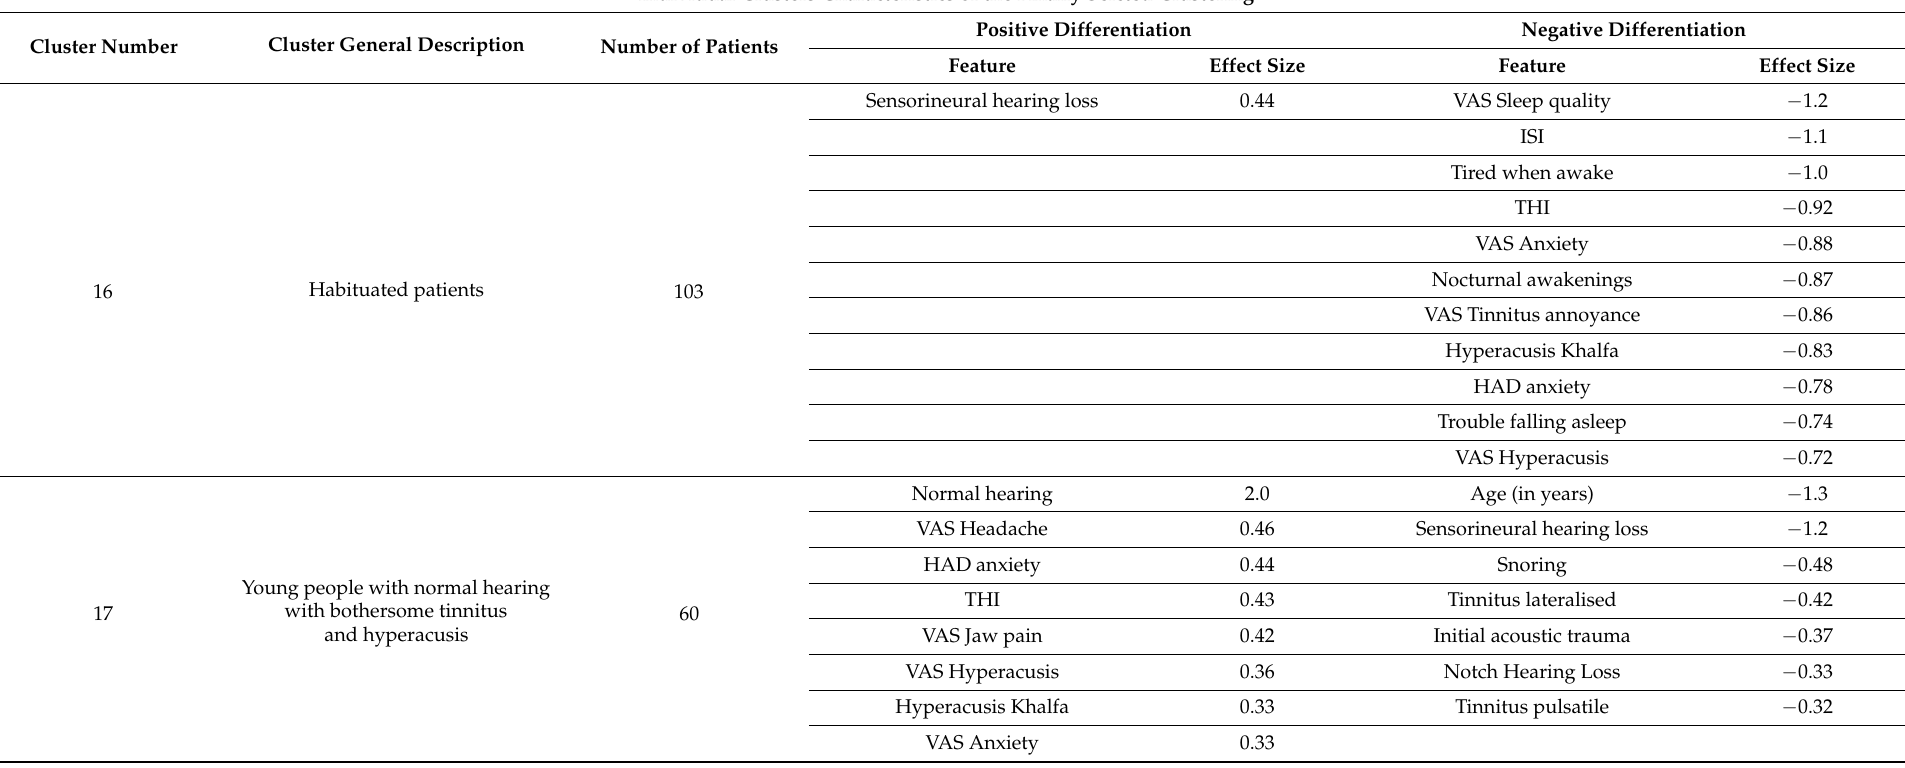
Table 7. Cont. Individual Clusters Characteristics of the Finally Selcted